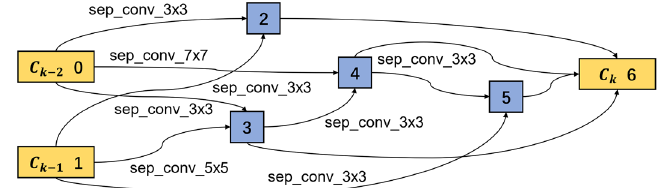
Figure 7. Structure of learned normal cell after 19 steps.